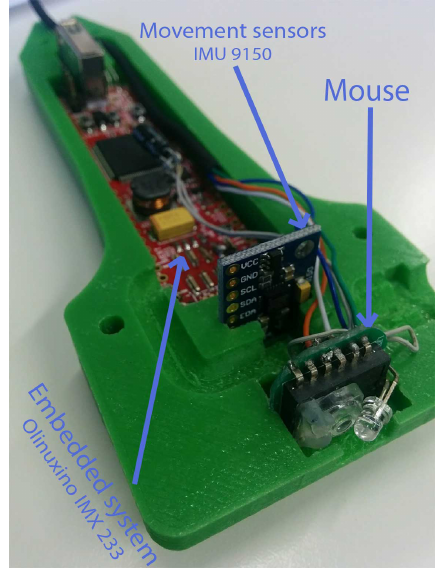
Figure 1. Arrangement of the hardware modules inside HUSP: optical mouse board, IMU and Linux embedded computer.